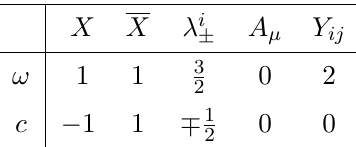
Table 9 . Weyl weight ! and SO(1 ; 1) R weight c for each vector multiplet component